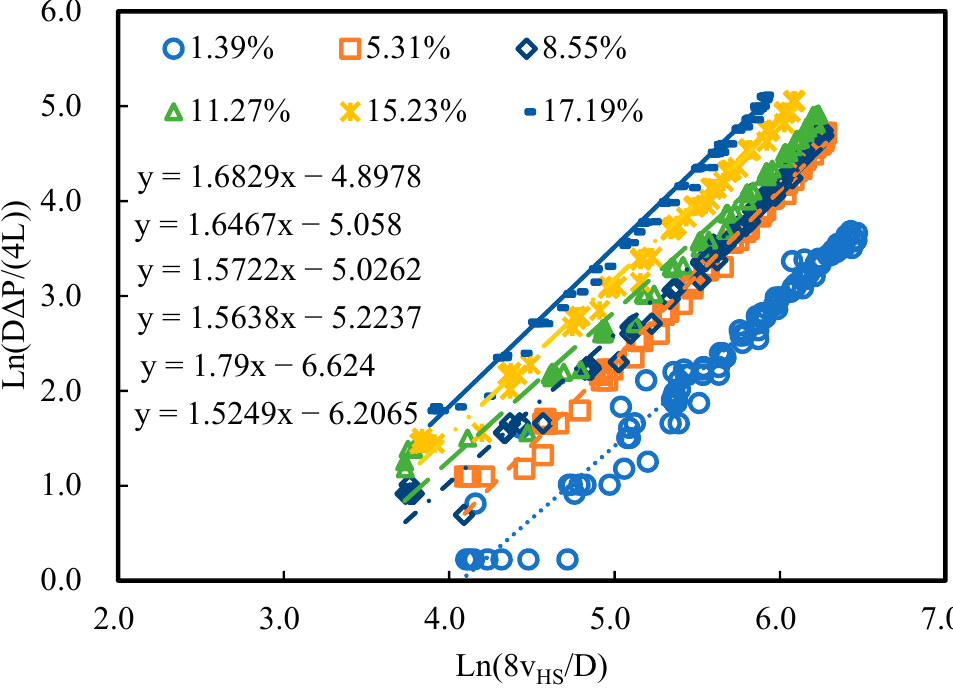
Figure 3. Representation of Ln(D ∆ P/(4 L)) and Ln(8v HS /D) for CO 2 hydrate concentrations from 1.39 to 17.19 vol%.